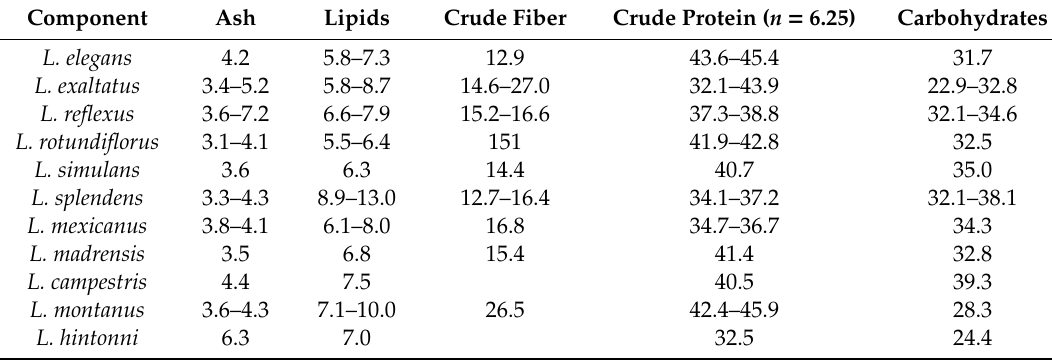
Table 8. Proximate composition of seeds from species of Mexican wild lupins (g / 100 g DM). Component